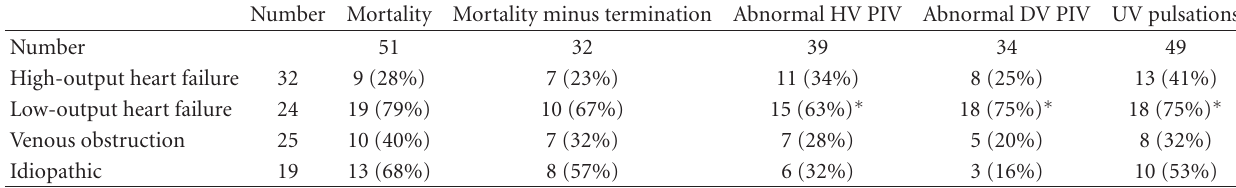
Table 2: Relationship between cause of hydrops and mortality and abnormal venous blood velocity.